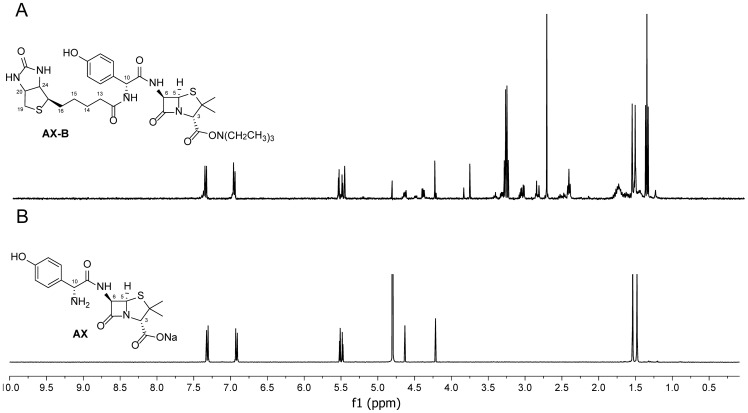

1H-NMR spectra of (A) AX-B and (B) AX recorded in D2O.